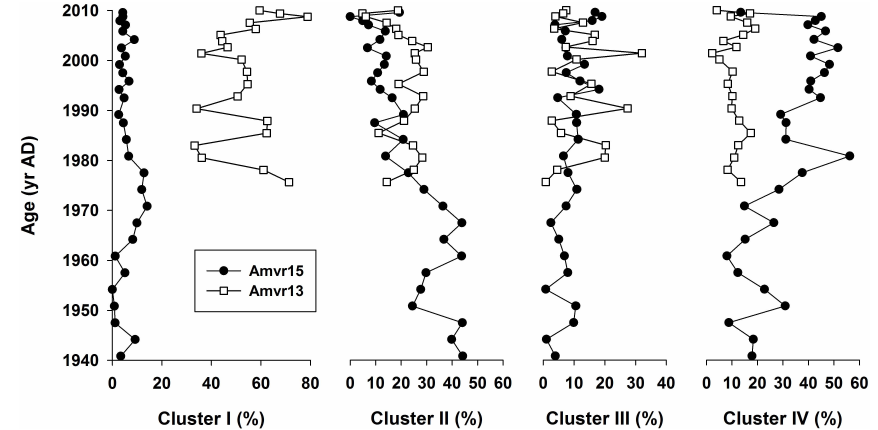
Fig. 10. Downcore variations of the sum abundances of the benthic foraminifera clusters (I–IV) in cores Amvr13 and Amvr15 vs. age